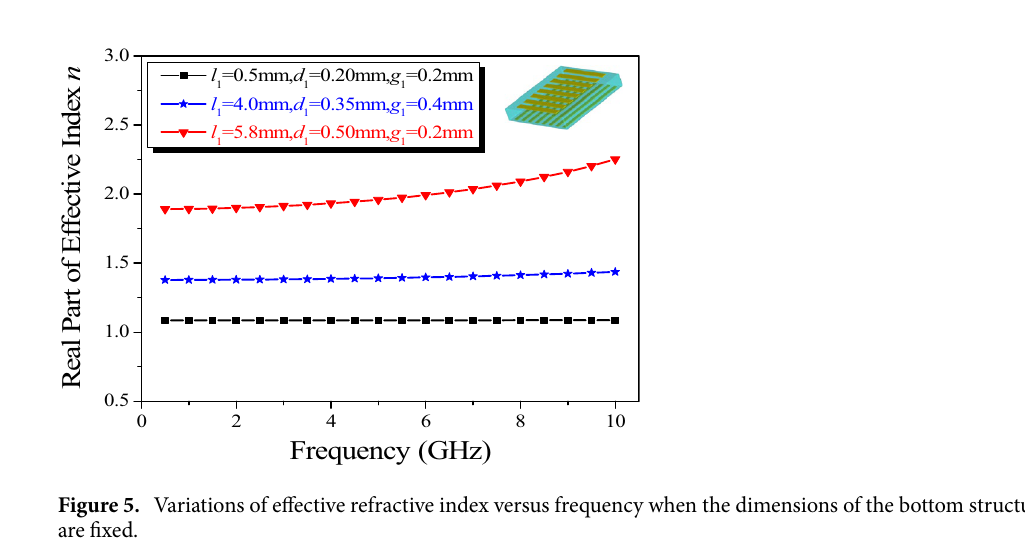
Figure 4. Variations of effective refractive index versus frequency when the dimensions of the top structure are fixed ( l